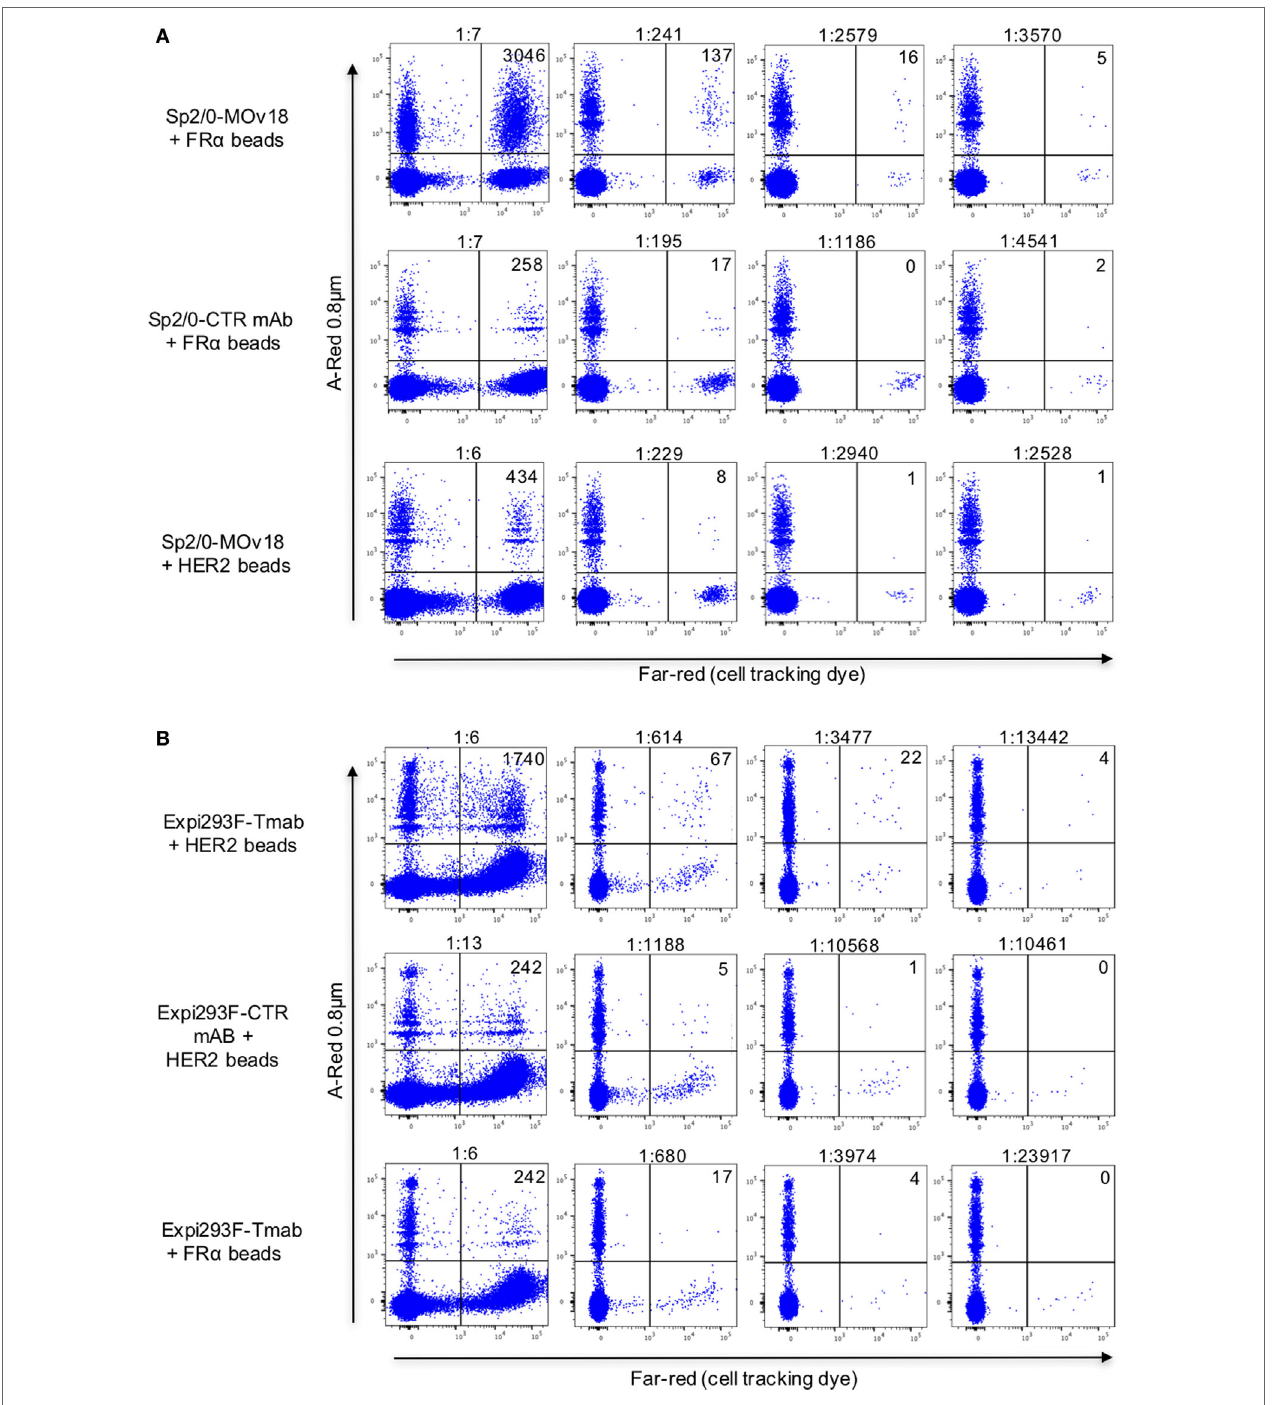
FigUre 7 | Detection of antibody-expressing or non-specific control antibody-expressing cells in peripheral blood mononuclear cells (PBMC) samples using fluorescent beads conjugated to recombinant antigens. (a) Flow cytometric dot plots of human PBMC incubated with FR α -coated A-Red 0.8 µm beads (top and middle) or with recombinant HER2-coated beads (bottom), spiked with different numbers of either Sp2/0-MOv18 cells (top and bottom), or non-specific SF25 control monoclonal antibody-expressing Sp2/0 cells (middle), pre-labeled with Far-red cell tracking dye. Actual dilutions (calculated post acquisition) are indicated above each dot plot. The actual dilution was calculated by dividing the number of live Far-red positive events (antigen specific cells) by the number of live Far-red negative events (PBMC). Numbers in each quadrant indicate the absolute number of bead-bound cells detected. (B) Flow cytometric analyses of human PBMC incubated with A-Red 0.8 µm beads coated with human recombinant HER2 (top and middle) or with FR α (bottom), and spiked with different numbers of Expi293F cells expressing an anti-HER2 antibody (trastuzumab, top and bottom) or non-specific monoclonal antibody control (anti-CSPG4, middle). Expi293F cells were pre-labeled with Far-red cell tracking dye. Numbers in each quadrant indicate the absolute number of cells detected by antigen-coated